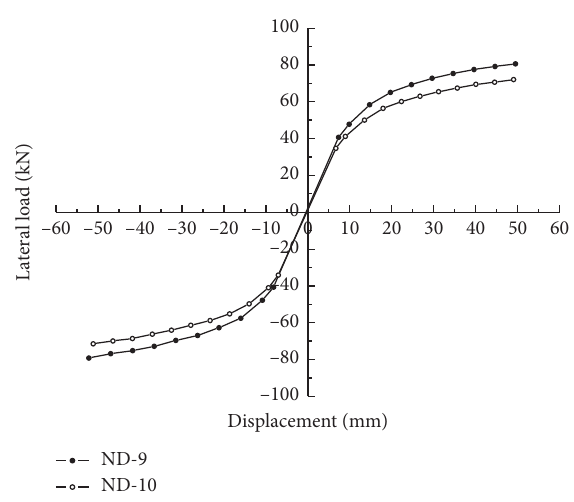
Figure 33: Skeleton curves of slit width 40mm.